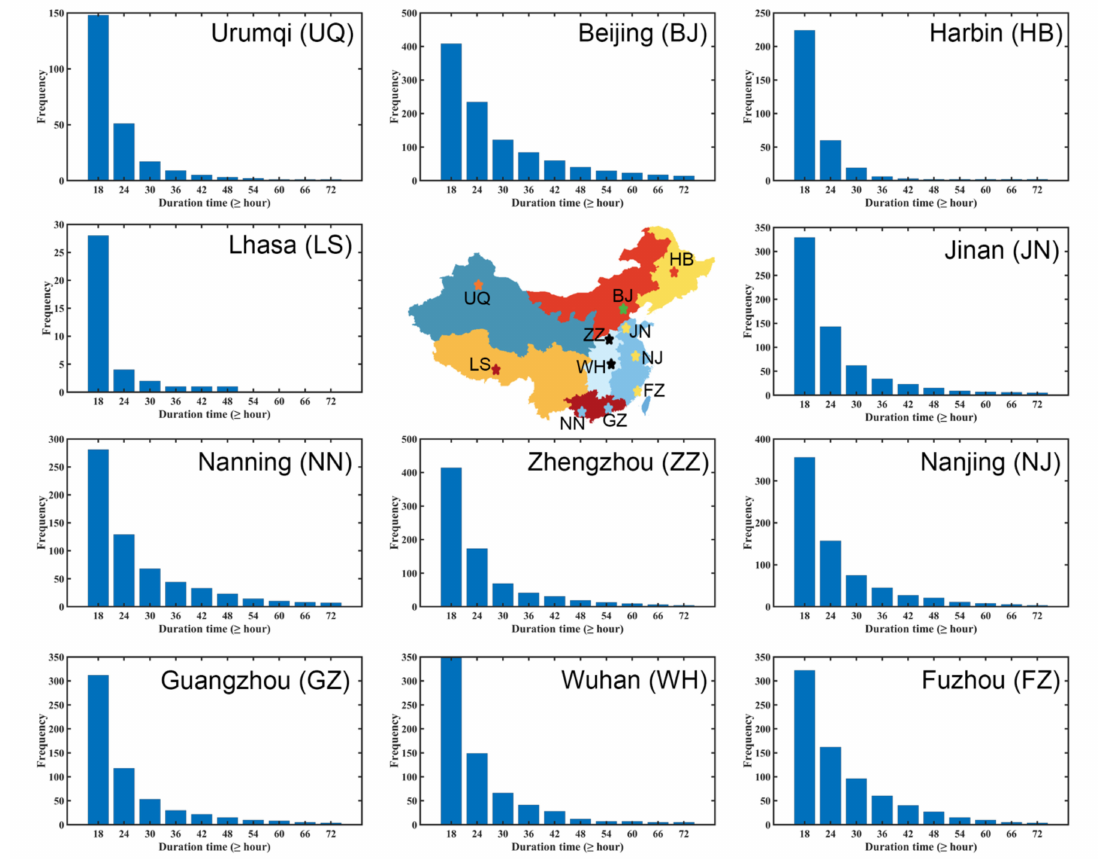
Figure 8. The distributions of duration time of PM 2.5 pollution processes in the 11 typical